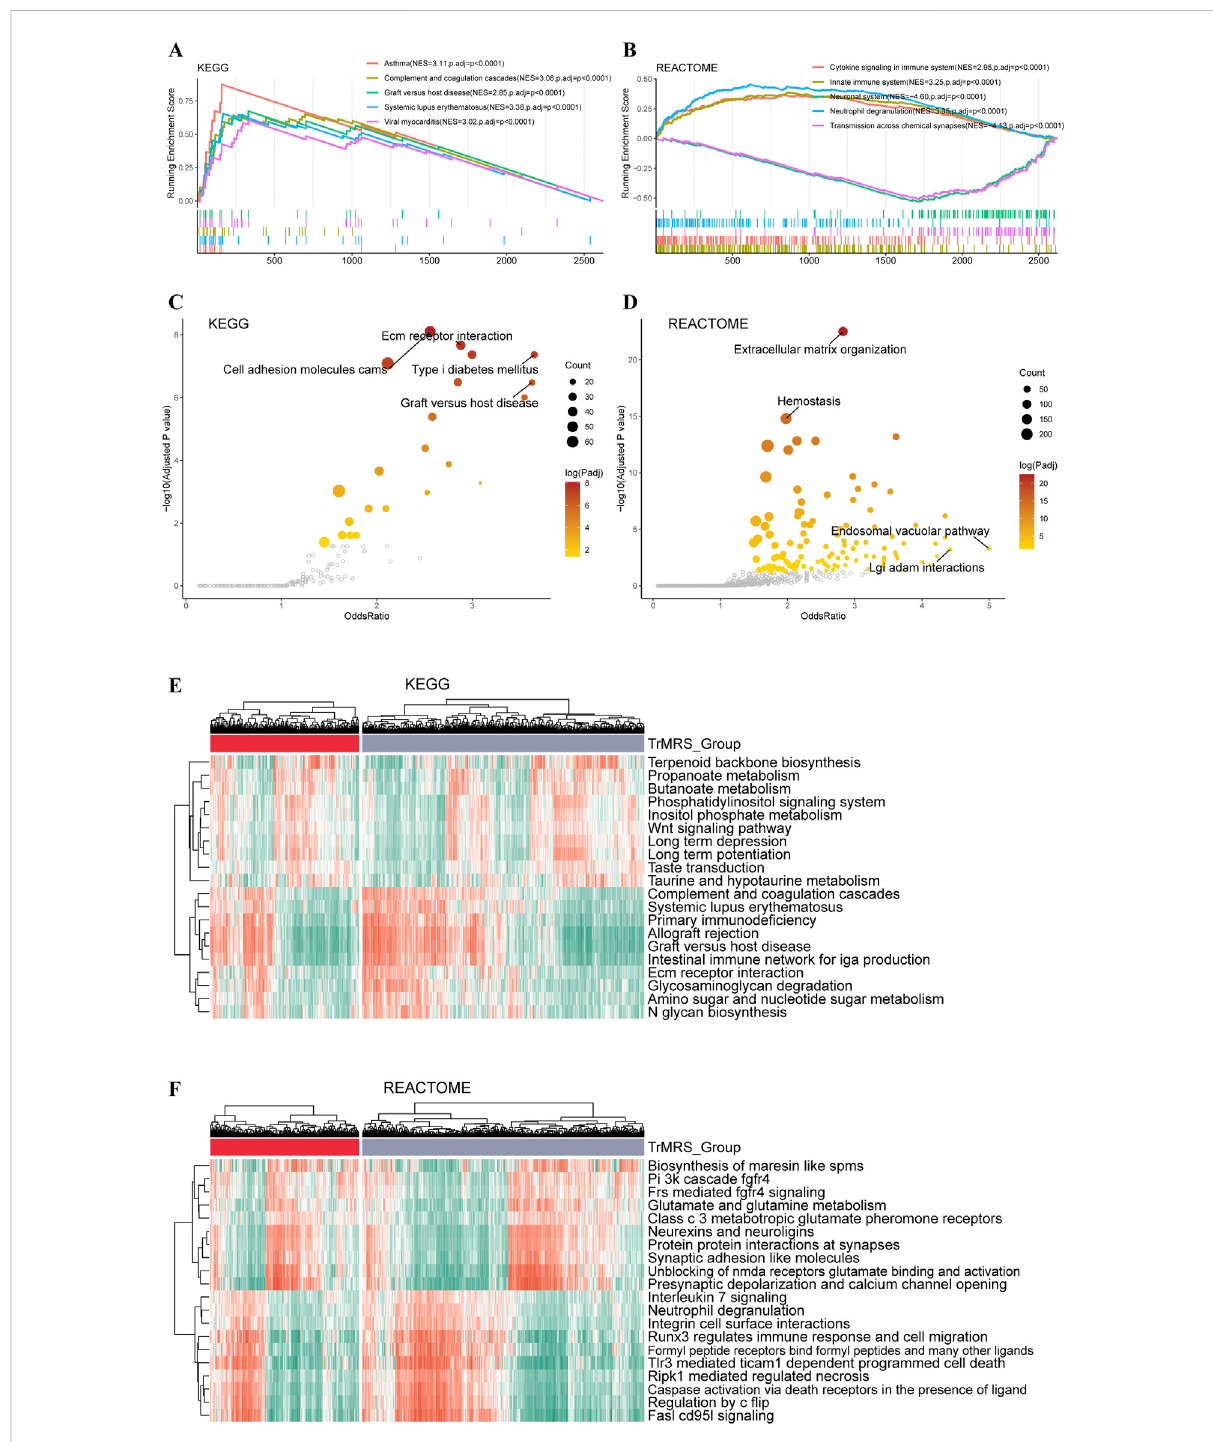
FIGURE 6 Functional enrichment analyses of the transcriptome of TrMRS risk groups. (A) The top fi ve pathways with the highest normalized enrichment score in the KEGG gene sets between two risk groups. (B) The top fi ve pathways with the highest normalized enrichment score in the REACTOME gene sets between two risk groups. (C) Pathways with high odds ratio and con fi dence in the KEGG and (D) REACTOME gene sets. (E) Top 20 differentially expressed KEGG gene sets ( N = 655, low-risk group: N = 429, high-risk group: N = 226). (F) Top 20 differentially expressed REACTOME gene